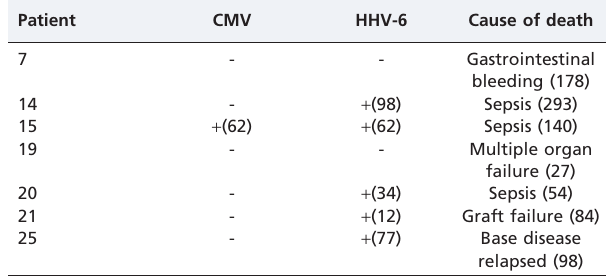
Table 3 - Cause of patient death and episodes of CMV and/or HHV-6 active